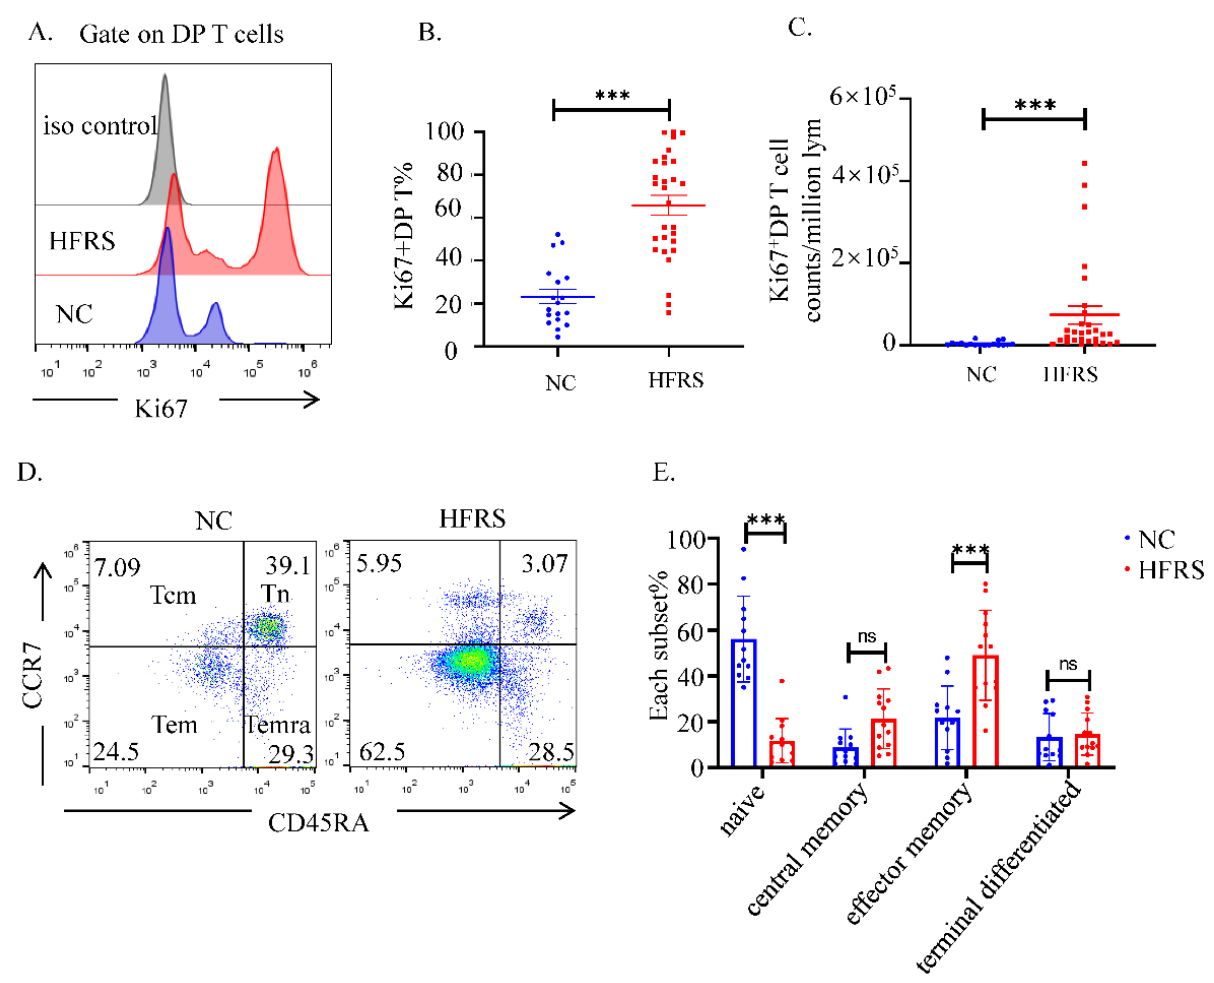
Figure 3. The activation status of DP T cells. ( A ). The expression of Ki67 in DP T cells was evaluated by flow cytometry. The representative histogram figures of Ki67 expression in DP T cells from both HFRS patients and NC, setting iso type staining as controls. ( B ) Comparison the percentage of Ki67 + DP T cells and the ( C ) MFI of Ki67 in DP T cells from both HFRS patients and NC (For HFRS, n = 29, For NC, n = 18). ( D ) T cell subsets are defined as naïve (Tn) (CD45RA+, CCR7+), central memory (Tcm) (CD45RA−, CCR7+), effector memory (Tem) (CD45RA−, CCR7−), and terminal effectors (Temra) (CD45RA+, CCR7−). The representative dot blot figures showed the activation status of T cell subsets in DP T cells. ( E ) The statistical analysis showed the comparison of each T cell subset in both HFRS patients and NC (For HFRS, n = 13. For NC, n = 12). *** p < 0.001; “ns” means no significance.